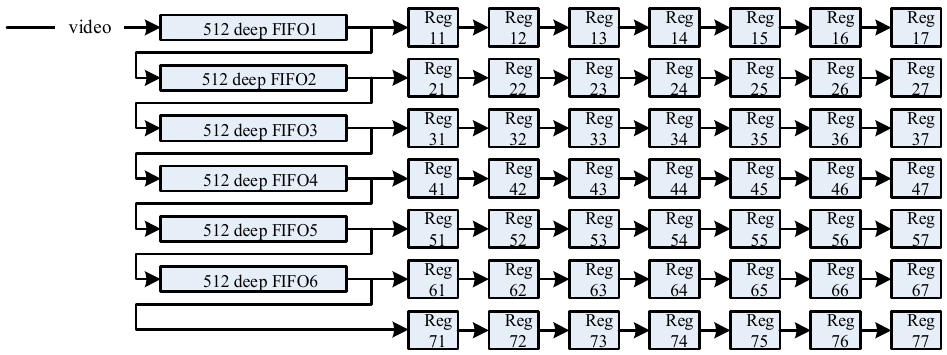
Figure 9. Diagram of filtering window in the FPGA.